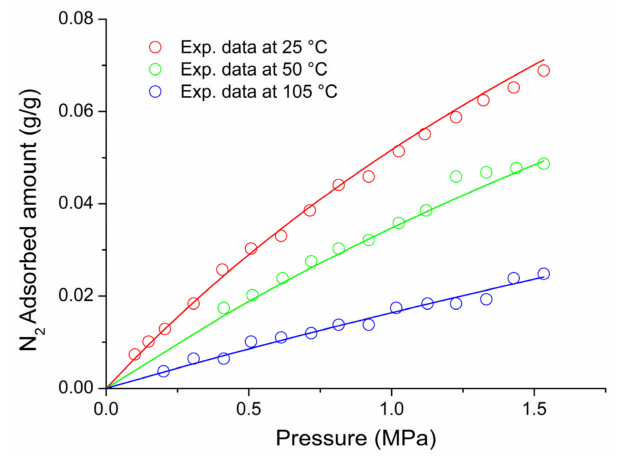
Figure 7. Comparison between experimental N 2 adsorption data in Cu-BTC [48] and simultaneous optimized RALF model fitting (solid lines).